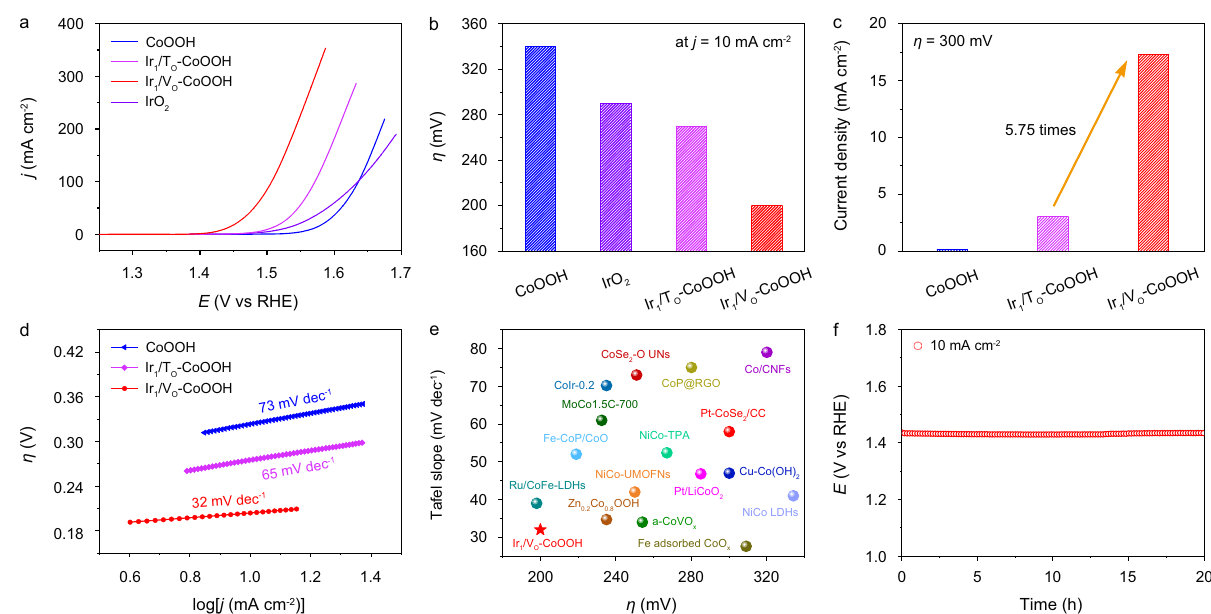
Fig. 3 Electrocatalytic performance towards OER. a Polarization curves of CoOOH, Ir 1 /T O – CoOOH, and Ir 1 /V O – CoOOH. IrO 2 was used as reference. The measurements were conducted in 1.0 M KOH. b Overpotentials at 10 mA cm − 2 for CoOOH, Ir 1 /T O – CoOOH, and Ir 1 /V O – CoOOH. c Speci fi c activities of CoOOH, Ir 1 /T O – CoOOH, and Ir 1 /V O – CoOOH normalized against ECSA at an overpotential of 300 mV. d Tafel slopes of CoOOH, Ir 1 /T O – CoOOH, and Ir 1 / V O – CoOOH. e Comparison of Tafel slopes and overpotentials at 10 mA cm − 2 for currently reported cobalt-based OER catalysts. f Chronopotentiometric curves of Ir 1 /V O – CoOOH towards OER at 10 mA cm − 2 for 20